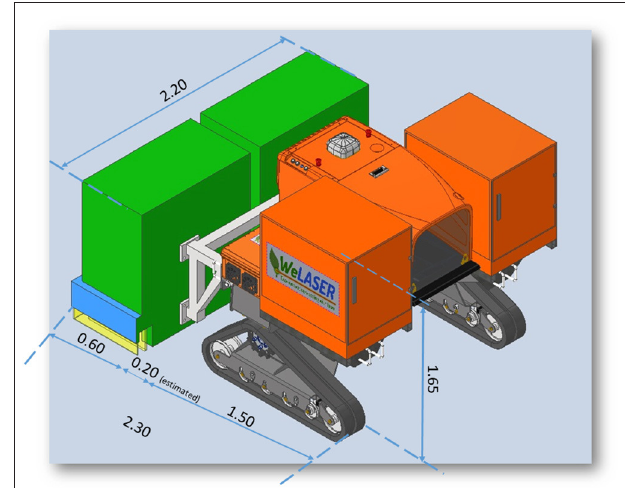
weeding (from https://welaser-project.eu/).